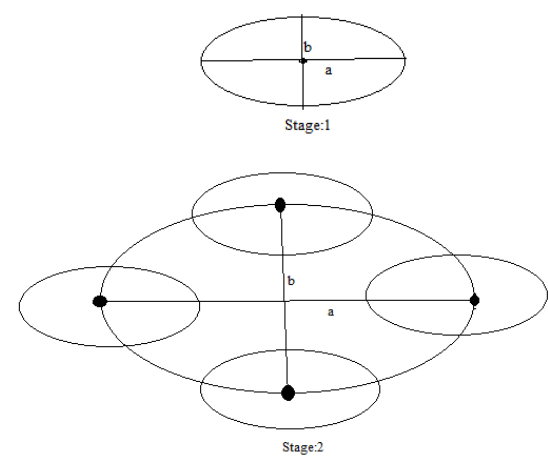
Figure 1. Concentric elliptical sub array generator for stage:1 and stage:2.